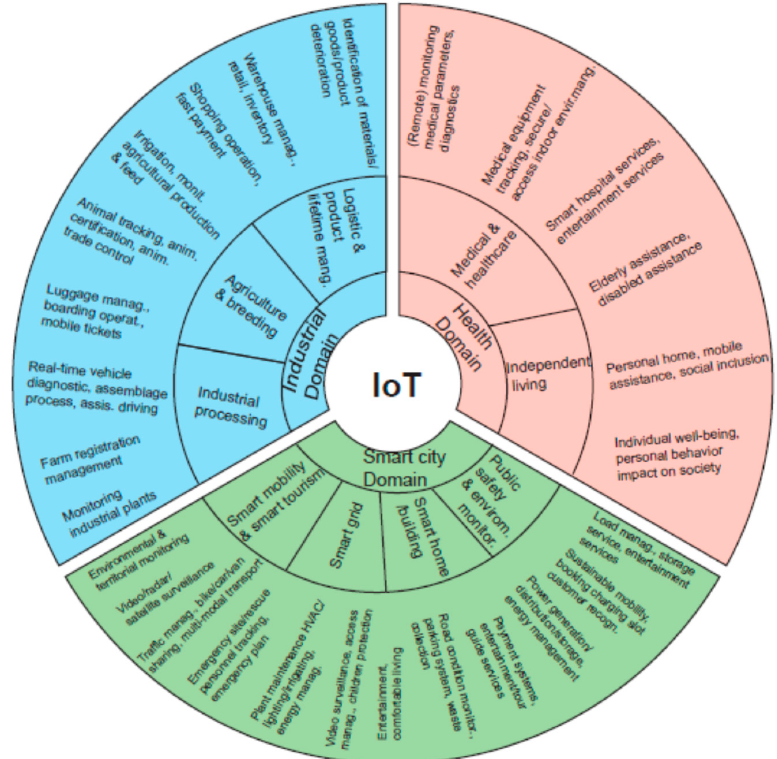
Figure 2. IoT application domains.